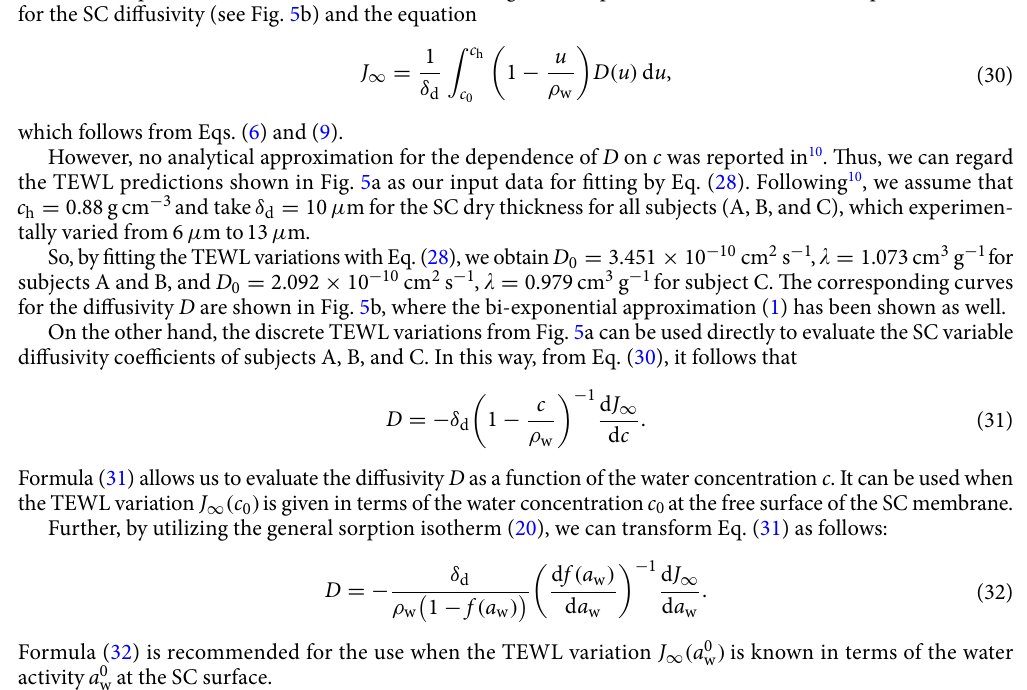
Figure 5. ( a ) Calculated in vivo steady-state water flux in stratum corneum J humidity; ( b ) Water diffusivity of stratum corneum D as a function of water concentration c . The symbolized points are adopted from 10